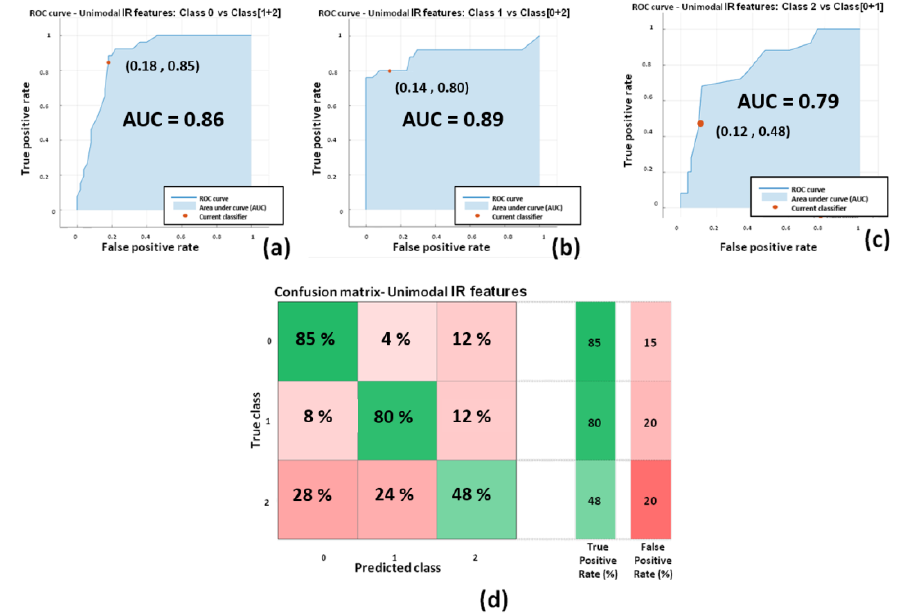
Figure 14. Performances of the Ensemble bagged trees for unimodal IR features-based classifiers for RAVLT: ( a ) ROC curve for the classifier of class ImmR (i.e., class 0) vs. cumulative class (DelR + Rec) (i.e., class 1 + 2); ( b ) ROC curve for the classifier of class DelR (i.e., class 1) vs. cumulative class